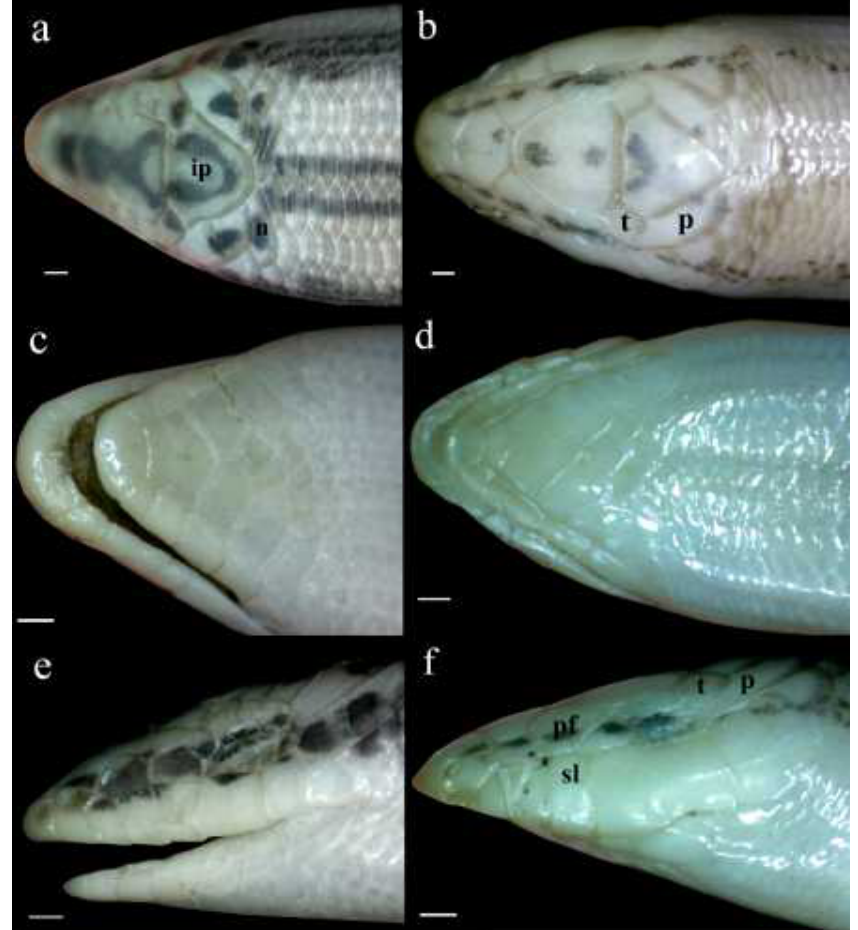
F IGURE 4. Dorsal (a, b), ventral (c, d), and lateral (e, f) views of head in Ophiomorus brevipes